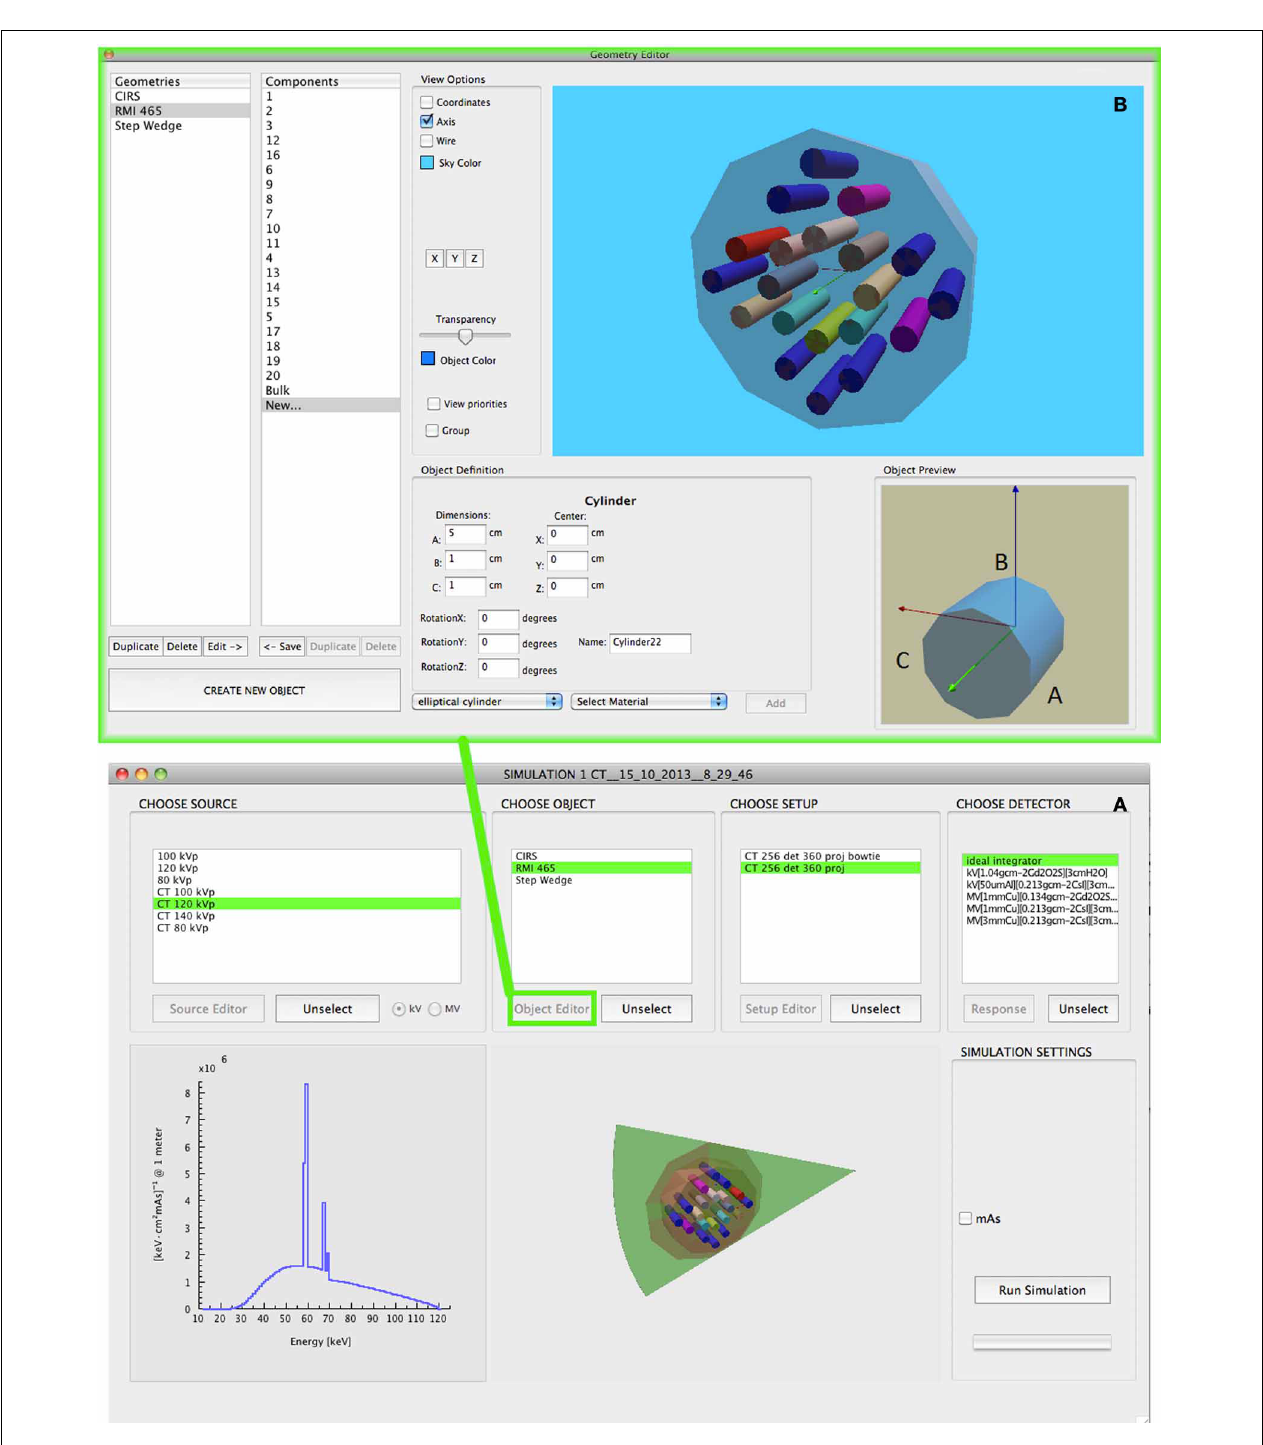
FIGURE 2 | (A) The main simulation window of ImaSim where a source, object, setup and detector type can be selected prior to running the simulation. Shown here is a CT simulation with an arbitrary CT phantom created with the object editor. Modality specific settings such as the live